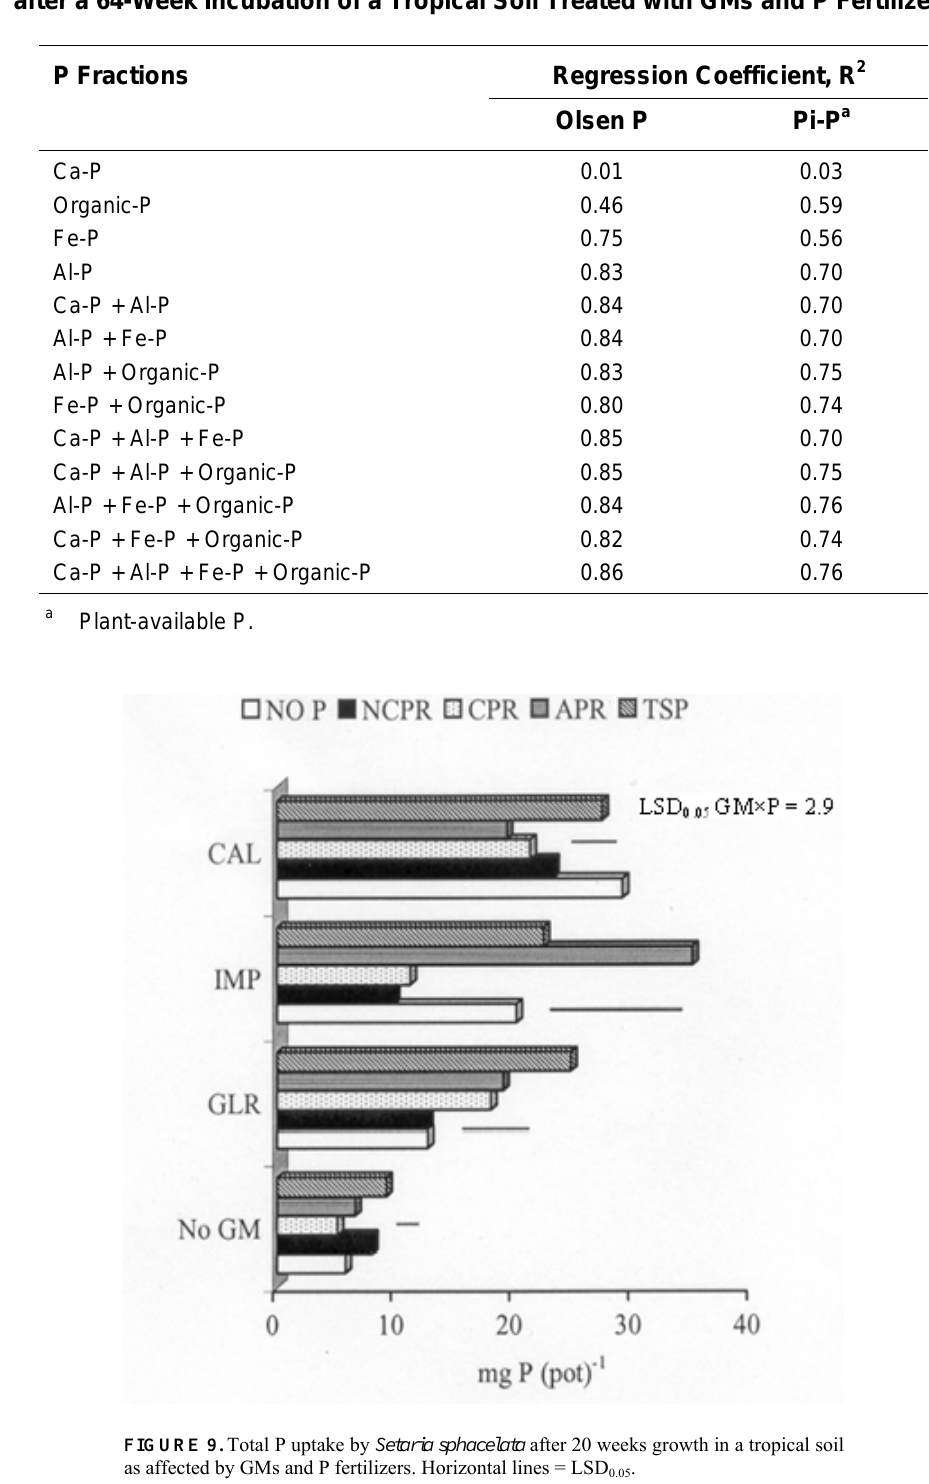
Stepwise Multiple Regressions Between Soil P Fractions and Available P after a 64-Week Incubation of a Tropical Soil Treated with GMs and P Fertilizers